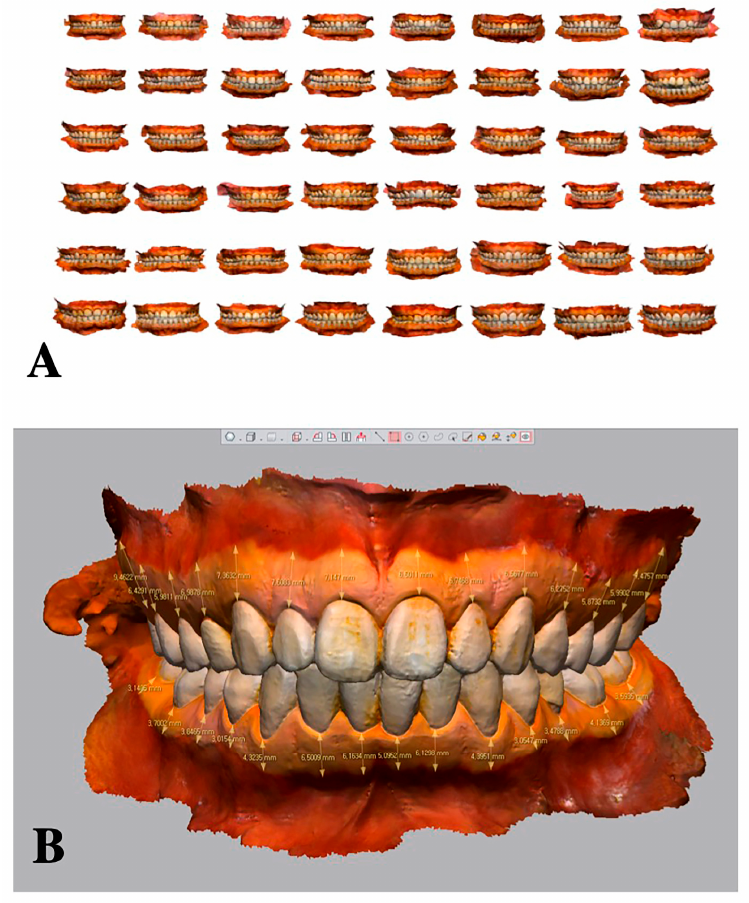
Figure 1. Intraoral scanning and measurement. ( A ) Intraoral scanning of the included participants, ( B ) measurement. ( B )